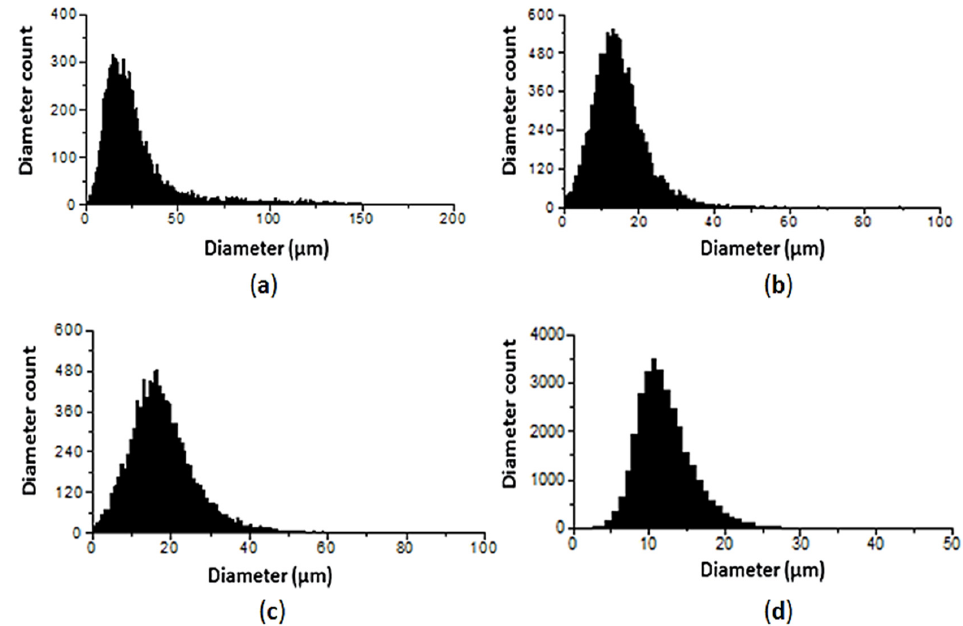
Figure 13. The influence of operation conditions on the atomization quality of the atomizer assembly.